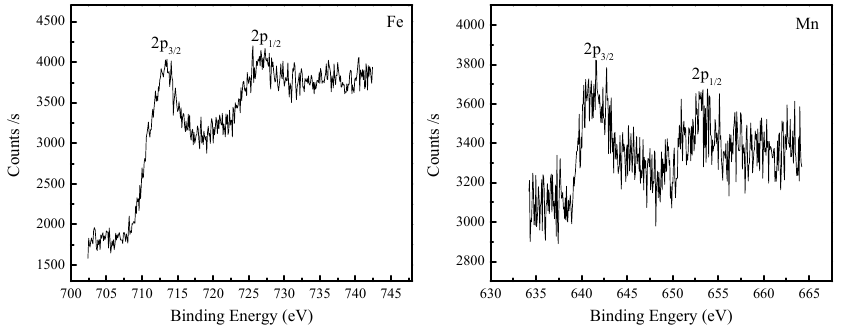
Figure 7. XPS spectra of Fe and Mn elements in the rust layer on medium-Mn steel after 432 h in a 3.5 wt % NaCl solution.